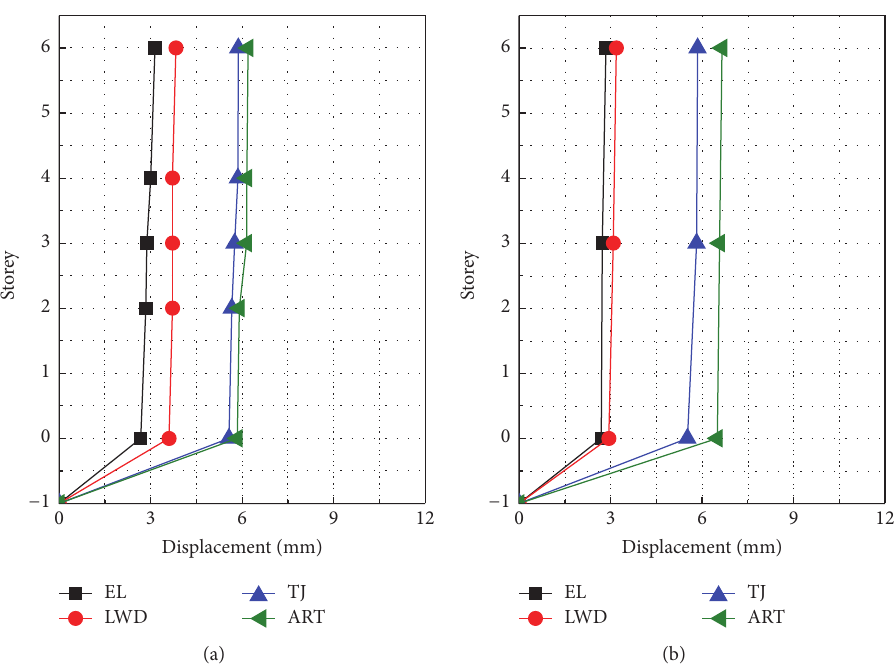
Figure 22: Profiles of maximum storey displacements of isolated structure under moderate earthquakes: (a) direction x ; (b) direction y .